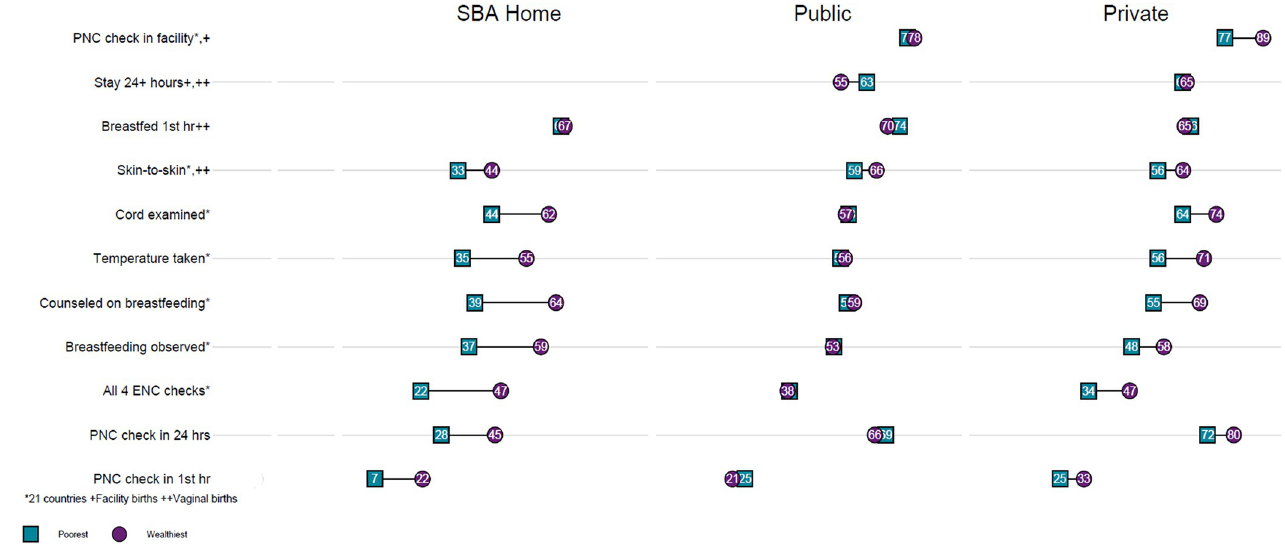
Fig 2. Receipt of ENC and PNC by newborns from the poorest and wealthiest households, by place of delivery.